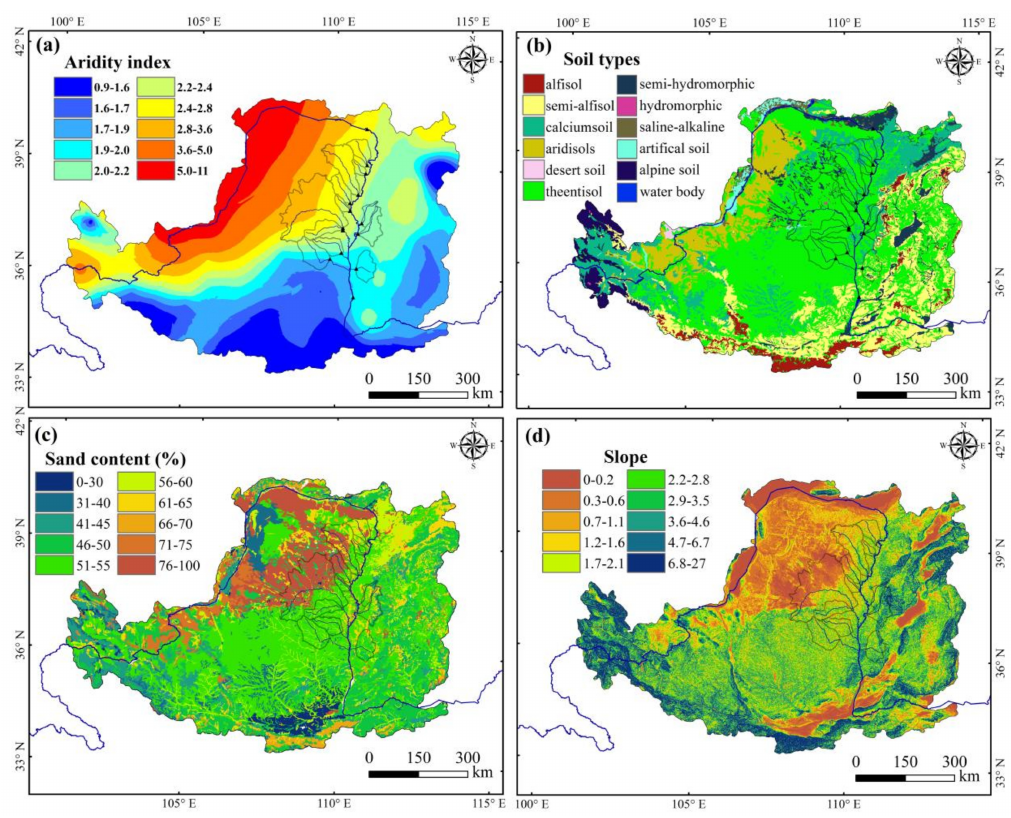
Figure 2. Climate, soil, and terrain characteristics: ( a ) aridity index, ( b ) soil types, ( c ) sand content, and ( d ) slope. Table 1. Basic hydro-meteorological characteristics of the 12 selected watersheds in the Loess